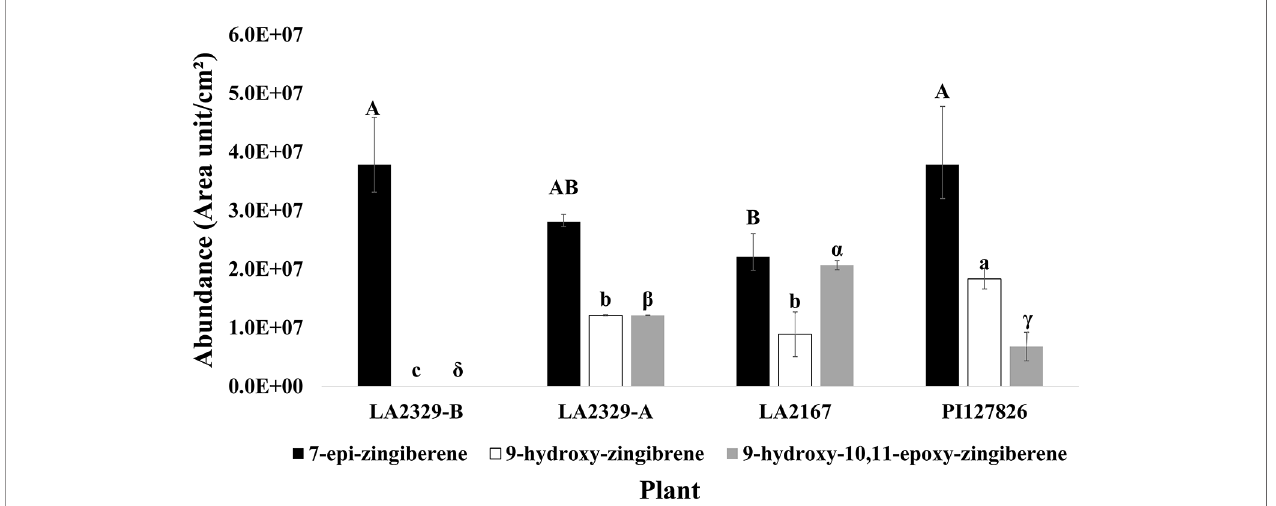
FIGURE 2 | Abundance of 7-epi-zingiberene, 9-hydroxy-zingiberene, and 9-hydroxy,10-11-epoxy-zingiberene in four plants, two chemotypes of LA2329 (LA2329-A and LA2329-B), LA2167 and PI127826. Abundance of a compound labeled by the same letter(s) are not signi fi cantly different (P < 0.05).